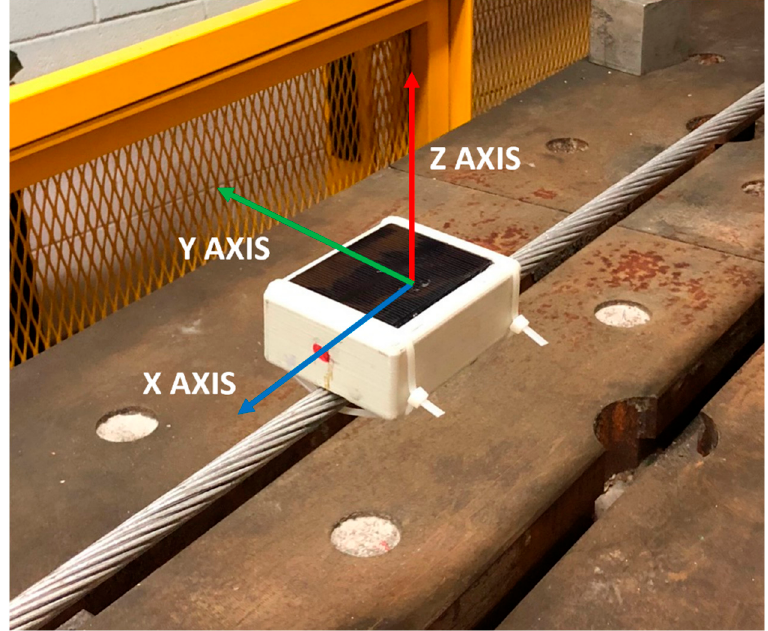
Figure 12. Accelerometer reference system with respect to the sensor node positioning on the conductor.